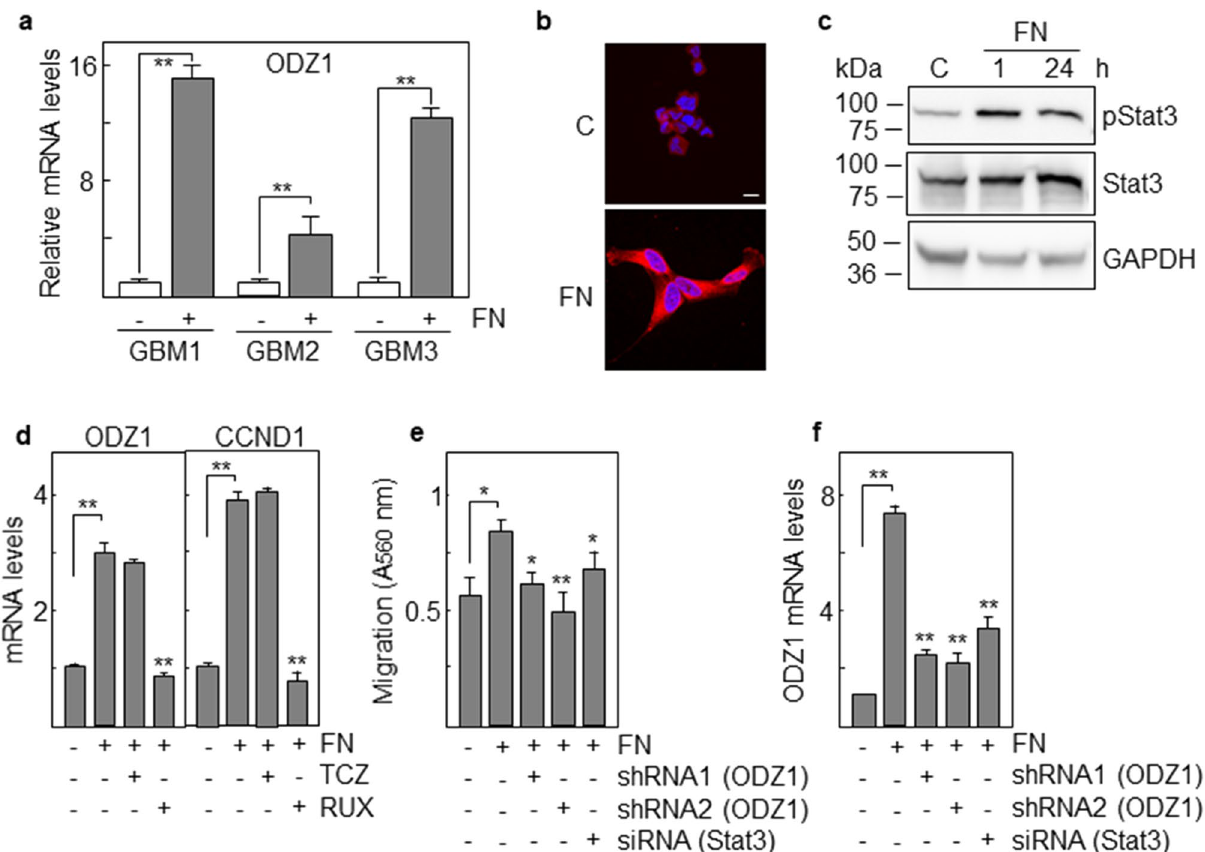
Figure 2. Fibronectin induces migration of GBM cells through Stat3-mediated expression of ODZ1. ( a ) GBM primary cell lines were cultured on a fibronectin (FN)-coated surface and three days later cells were analyzed for the expression of ODZ1 mRNA by qPCR. ( b ) GBM1 cells were cultured as above and then immunolabeled with anti-ODZ1 antibodies and the signal visualized by immunofluorescence. Samples were counterstained with DAPI to label nuclei. Scale bar: 5 μm. ( c ) Western blot analysis of phosphorylated Stat3 in GBM1 cells cultured in the presence of FN for 1 and 24 h. Stat3 and GAPDH were used to assure equal loading. ( d ) GBM cells were incubated with fibronectin (FN) in the presence of the inhibitors TCZ and RUX and the expression of ODZ1 and CCND1 was assessed by qPCR. ( e ) GBM1 cells transfected with two different ODZ1-specific shRNAs or a mixture of Stat3-specific siRNAs were cultured on FN and their migration capacity was determined using a Boyden-like system. ( f ) Cells cultured as described in ( e ) were analyzed for the expression of ODZ1 by quantitative PCR. Irrelevant shRNA or siRNAs (−) were used as negative controls. Histograms represent the mean of three independent experiments ± S.D. *p < 0.05, **p <